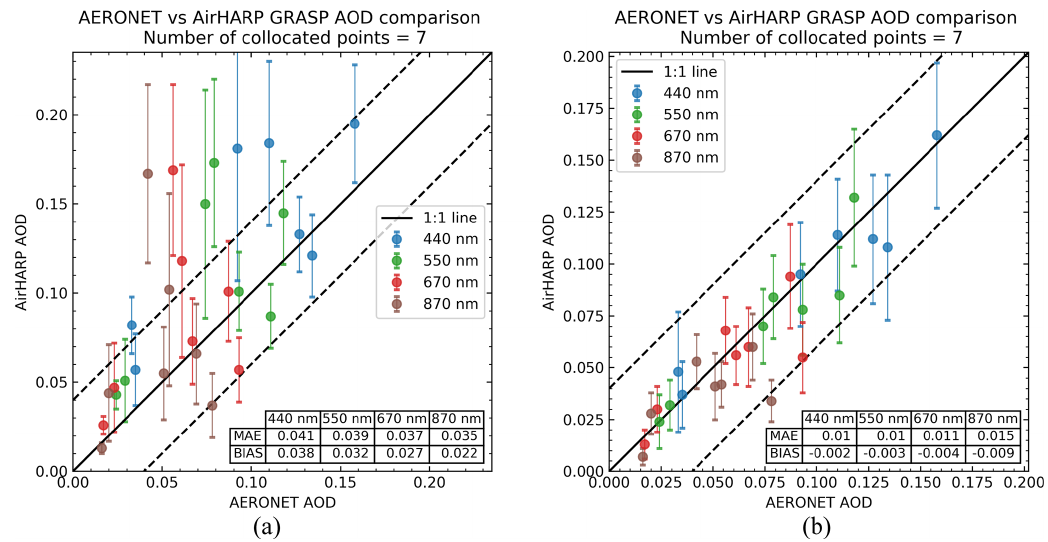
Figure 14. Scattergrams of aerosol optical depth (AOD) retrieved using AirHARP observations over collocated AERONET stations vs. AERONET-measured AOD interpolated to AirHARP spectral bands. Plotted are the areal mean AirHARP AODs calculated from all the qualified retrievals within a box of 5.5km × 5.5km around the AERONET station against the collocated AERONET temporal mean AOD. Each colored error bar indicates the SD of AOD within the areal box. Mean absolute error (MAE) and BIAS for each spectral band are provided in the table inside the scattergram. The black solid lines in the plots are the 1 : 1 lines, and the dashed lines are ± 0.04 AOD from the 1 : 1 line. (a) GRASP retrievals using the GRASP/Five mode kernel (Table 3) that has 15 free parameters and allows for retrieval of particle properties along with AOD; (b) same as (a) except using the GRASP/Models kernel (Table 4) that reduces free parameters to six, fixes particle properties based on Table 4 and only retrieves the concentration for each aerosol